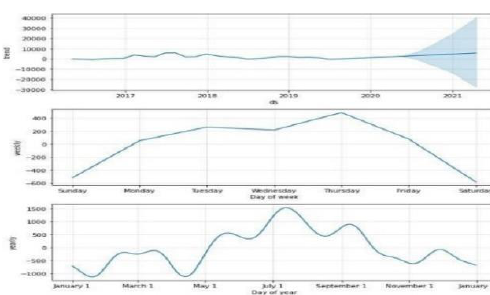
Fig 18. Forecast components yearly, monthly and trend-wise for Ether